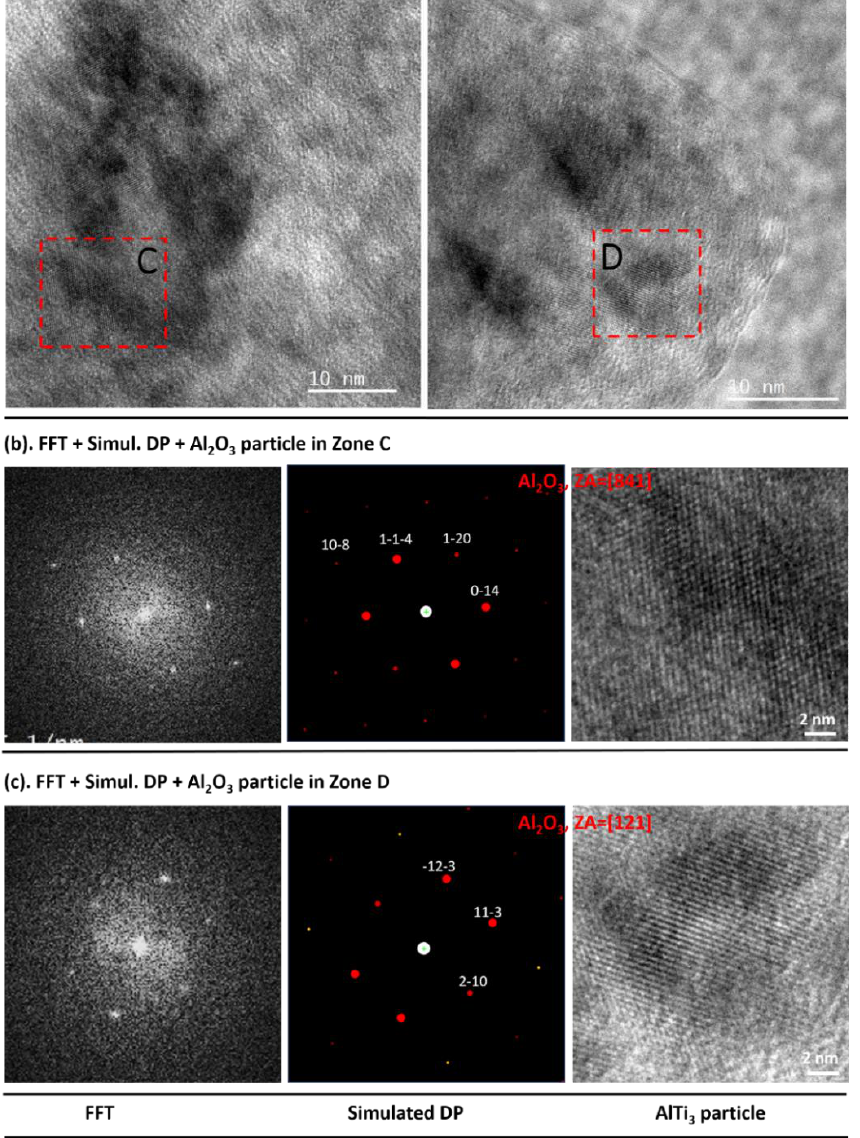
Figure 3. HR-TEM characterization of Al 2 O 3 nanoparticles in NaH + 3TiCl 3 · AlCl 3 material after washing: ( a ) Bright field TEM image captured with original width; ( b ) FFT + simul. DP + particle in zone C; and ( c ) FFT + simul. DP + particle in zone D. FFT was calculated in each region and compared with simulated diffraction patterns (DPs) in the adequate orientation; the width of the FFT and corresponding simulations are 18 nm −1 .